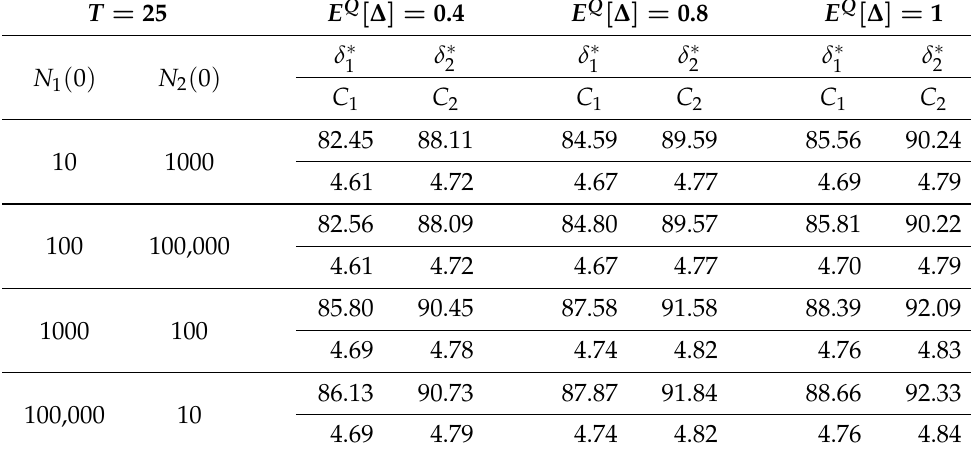
Table 4. Fair participation rates and certainty equivalent returns for Case 1 with T = 25, different portfolio sizes with N 1 ( 0 ) (cid:54) = N 2 ( 0 ) and different values of E Q [ ∆ ] . All results are in